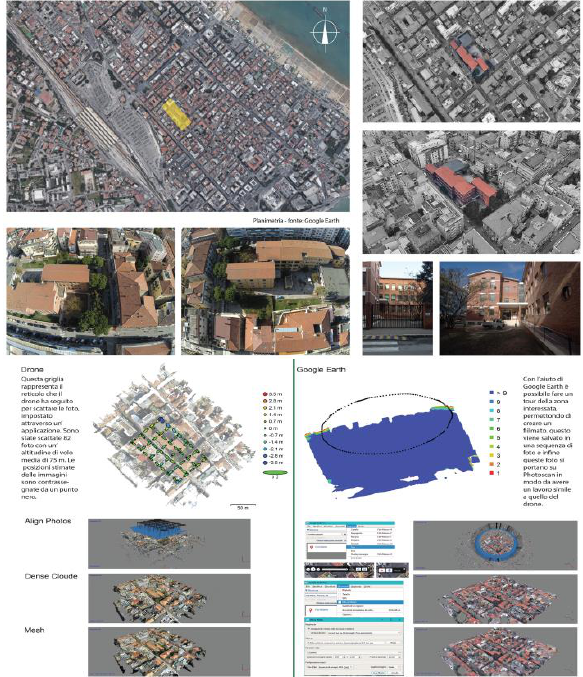
Figure 2. Comparative photogrammetric modelling phases: data acquisition from drone and Google Earth of G. Pascoli school.